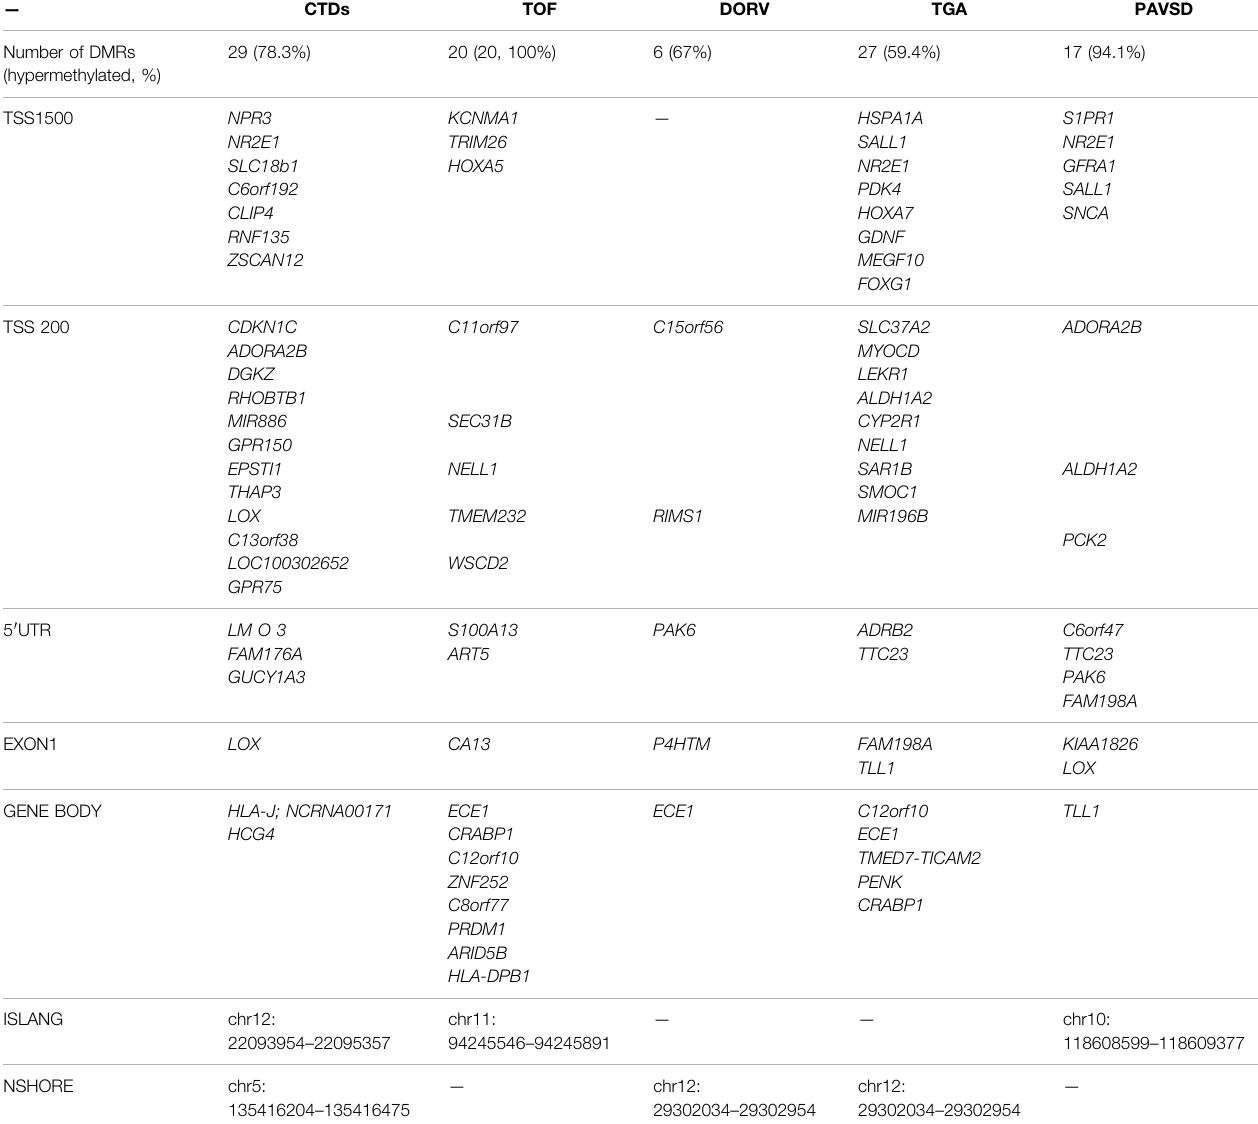
TABLE 3 | Genes with differential methylation regions in each group. — CTDs TOF DORV TGA Number of DMRs (hypermethylated,